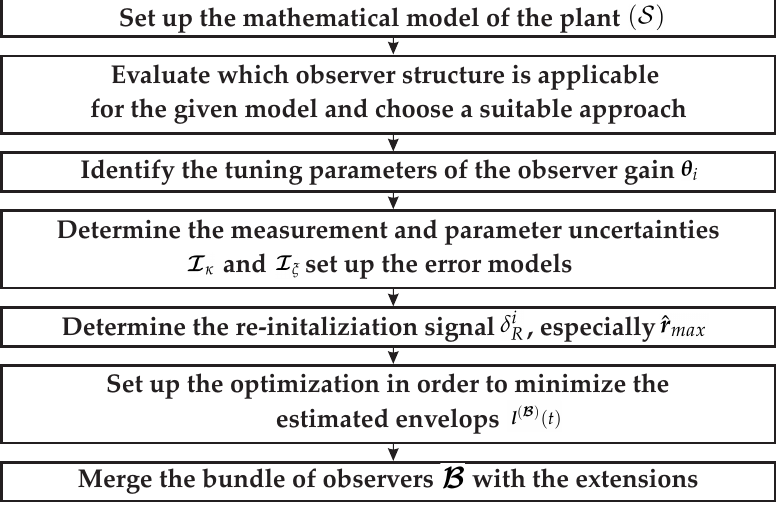
Figure 10. Flowchart of the design